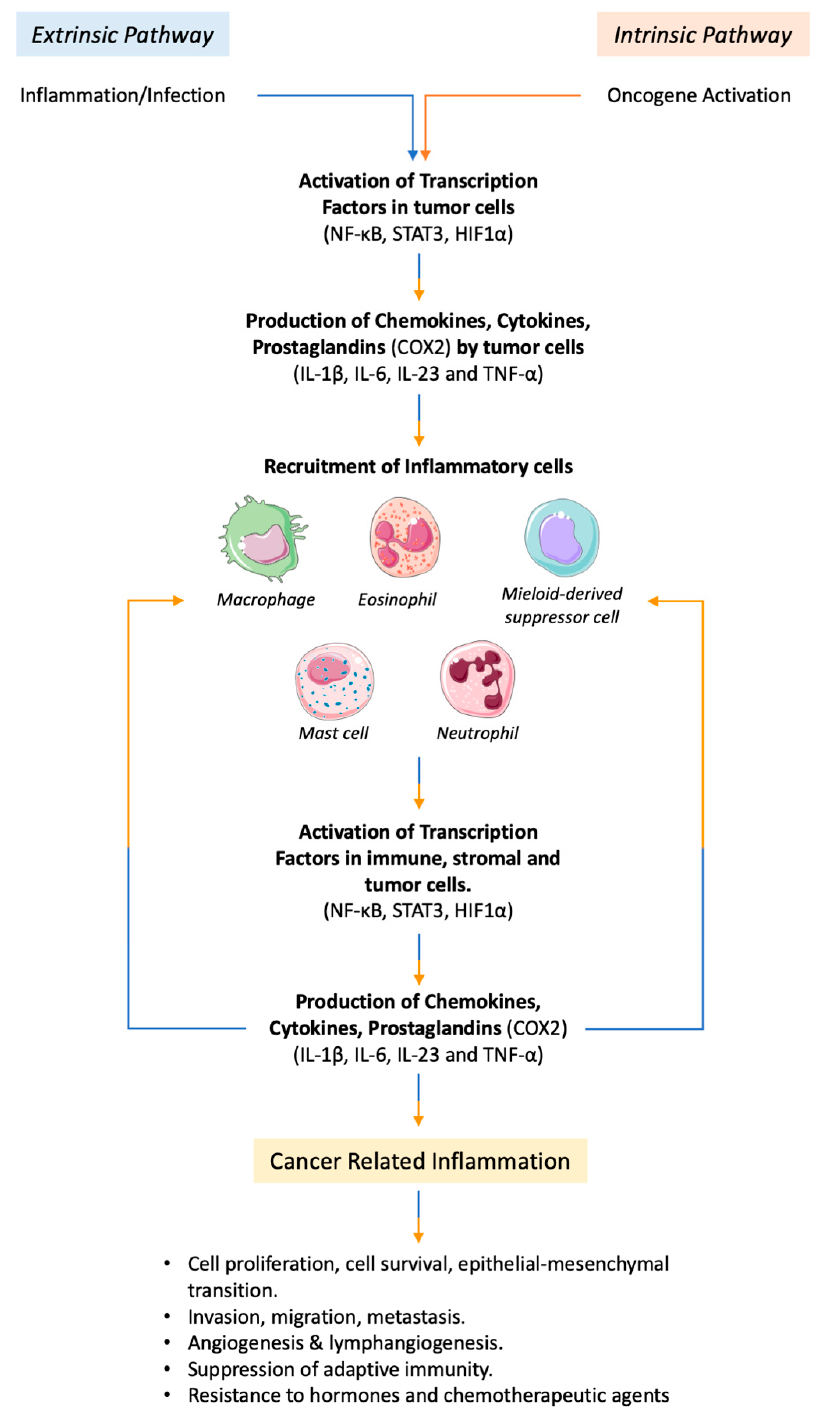
Figure 1. Inflammation and cancer connection pathways. An intrinsic and an extrinsic pathway connect inflammation and cancer. The extrinsic pathway is triggered by inflammatory or infectious conditions that increase tumor risk. In the intrinsic pathway, genetic alterations induce inflammation and tumor development. Although they have a different origin, both pathways converge in the activation of key transcriptional factors and inflammatory mediators, which are responsible for the recruitment of inflammatory cells. Once recruited, these cells fuel the process of cancer-related inflammation and tumor development. This figure was made with Servier Medical Art templates, which are licensed under a Creative Commons Attribution 3.0. Unported License (https://smart.servier.com)